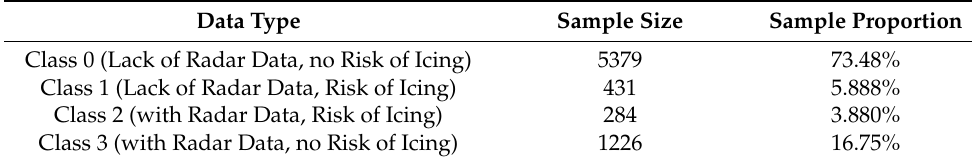
Table 1. Correspondence between cloud radar data and